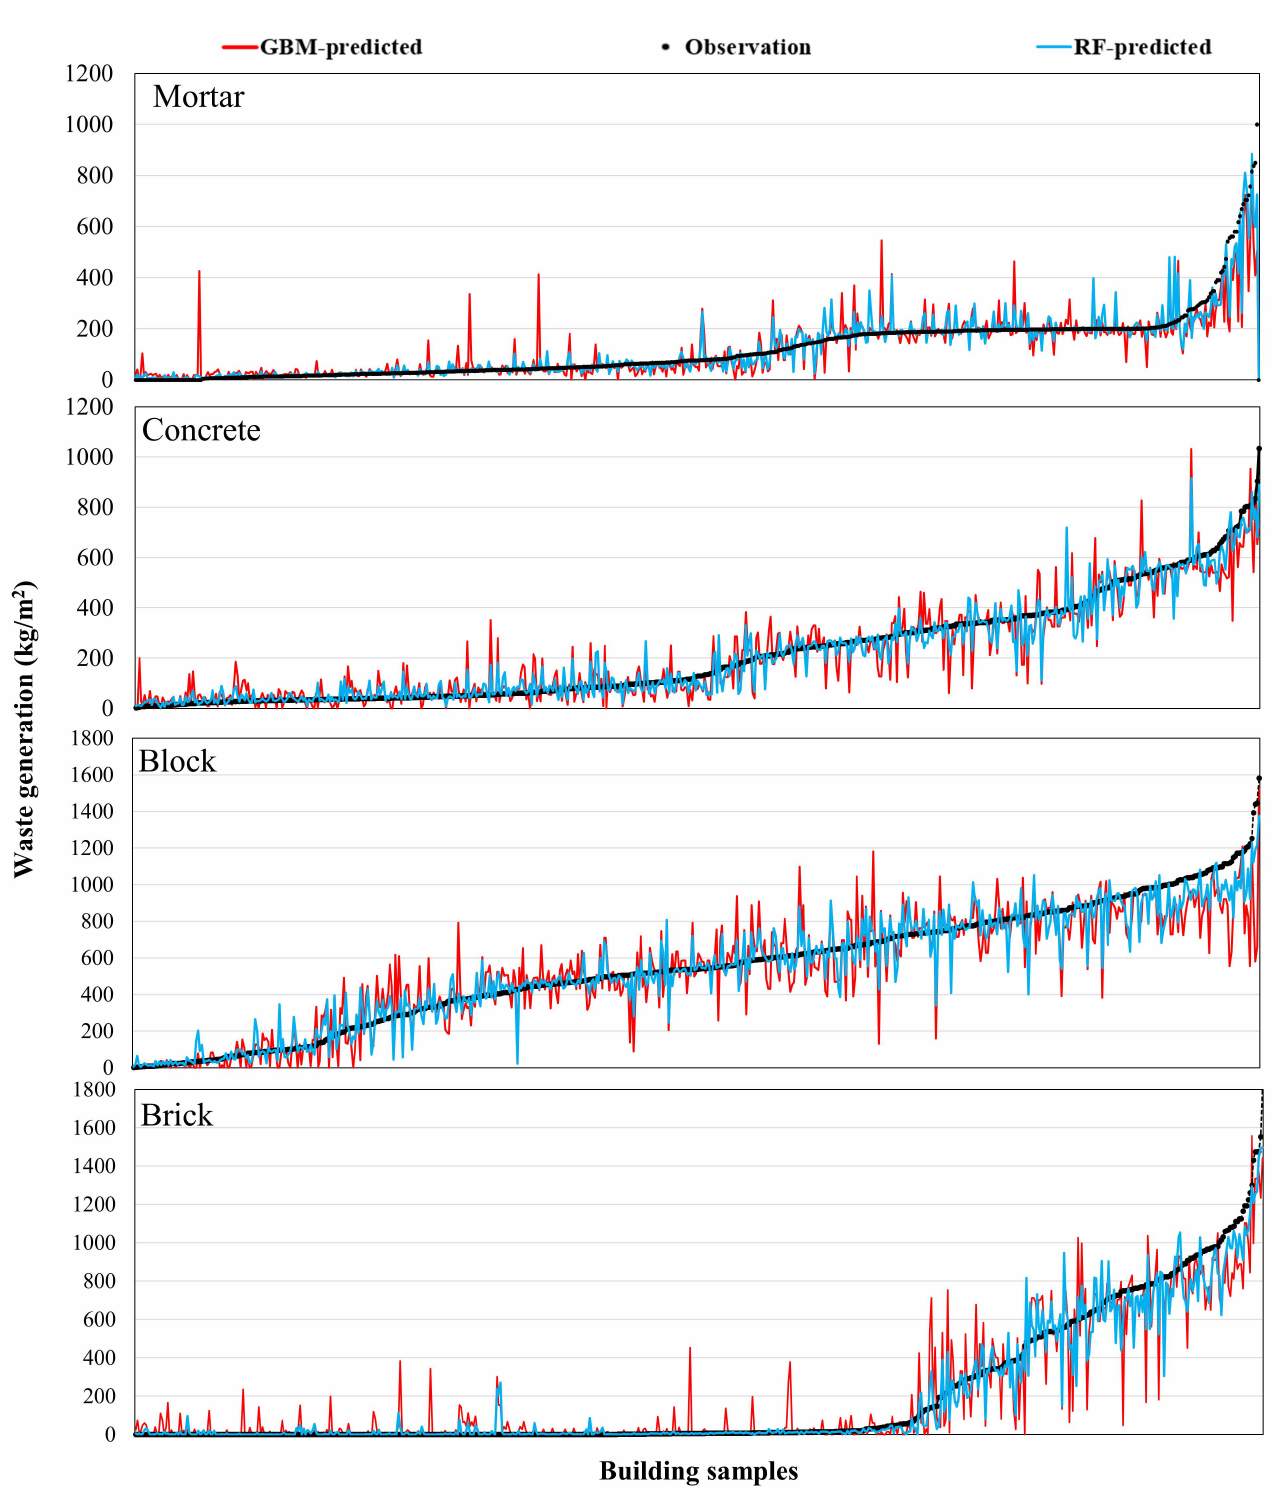
Figure 6. Comparison of the observed and predicted DW generation (kg/m 2 ) with the estimated ML models using RF and GBM for mortar, concrete, block, and